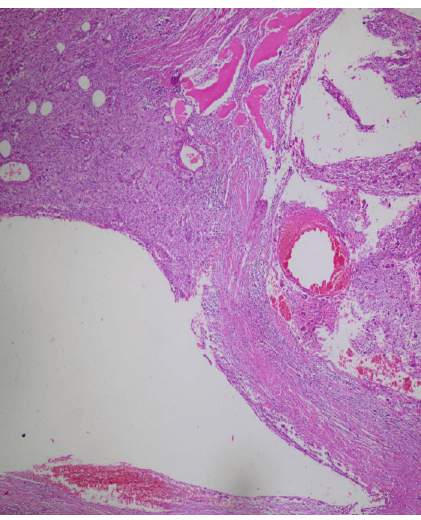
Figure 5: Hemorrhagic areas and aneurismal bone cyst-like